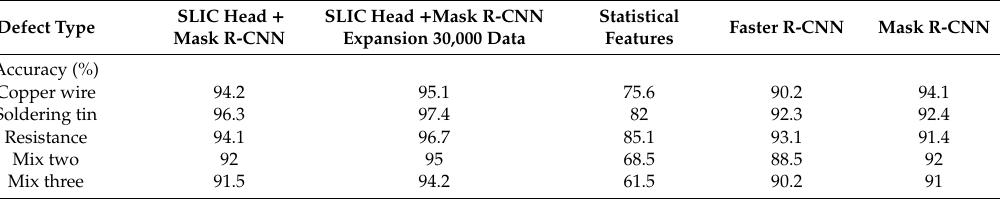
Table 2. The characteristics of traditional machine vision capture detection methods are not defined by the standard parts, especially in many tests to ensure robustness. In the R-CNN class network, due to the particularity of the non-standard parts, characteristics of the mask in absent places is important, so our network achieved a better e ff ect, as shown by the constant expansion of the dataset, with the help of further expansion e ff ect.